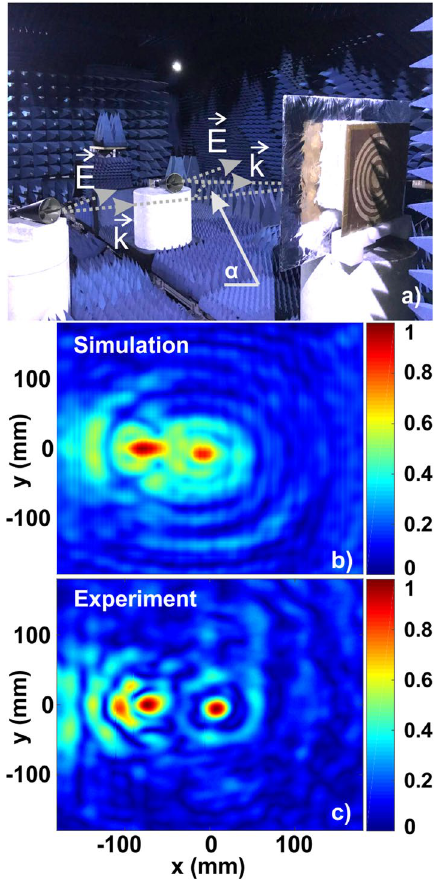
Figure 8. ( a ) DoA experimental setup for angular resolution. ( b , c ) Numerical and experimental field intensity distributions (normalized to maximum) at the lens’s focal